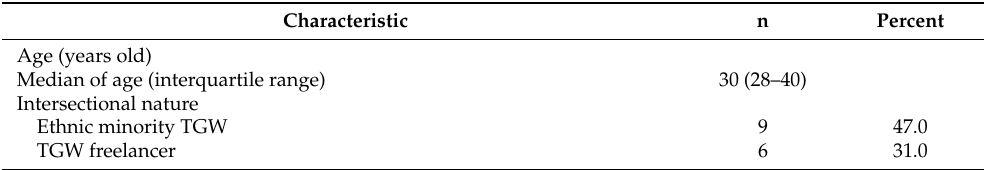
Table 1. The characteristics of the